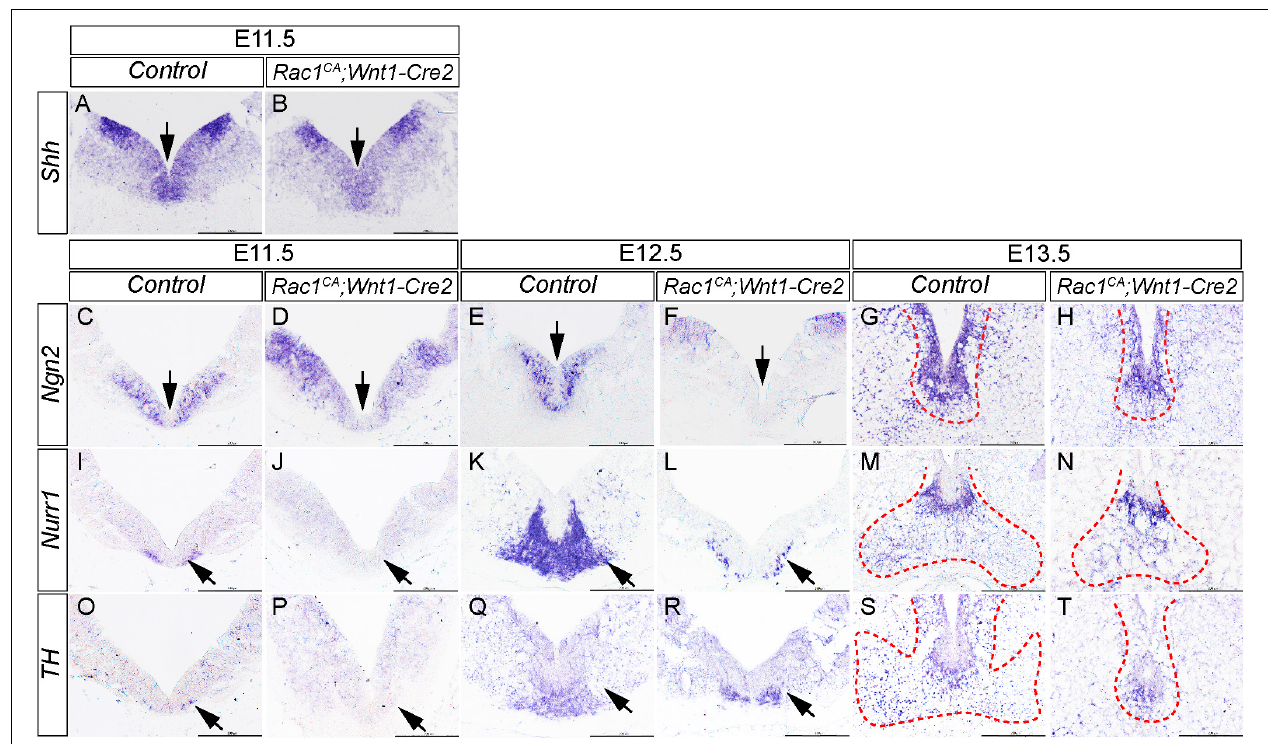
FIGURE 7 | Elevated Rac1 activity disrupts mDA differentiation in ventral midbrain. (A,B) In situ hybridization with Shh antisense probe on coronal sections of E11.5 littermate control and Rac1 CA ;Wnt1-Cre2 embryo. Arrows point to ventral midbrain. (C–T) In situ hybridization with antisense probes of Ngn2 (C–H) , Nurr1 (I–N)